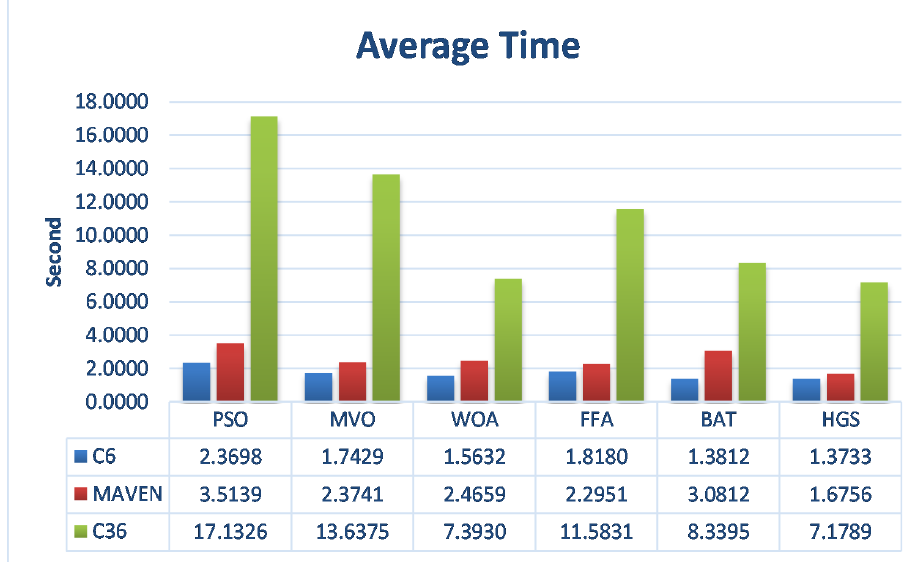
Figure 7. Average execution time of each FS